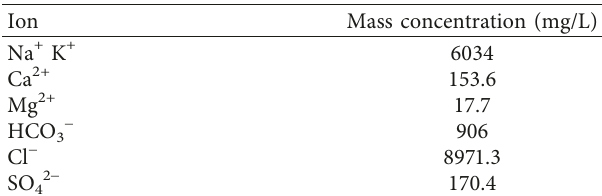
Table 3: Brine ion